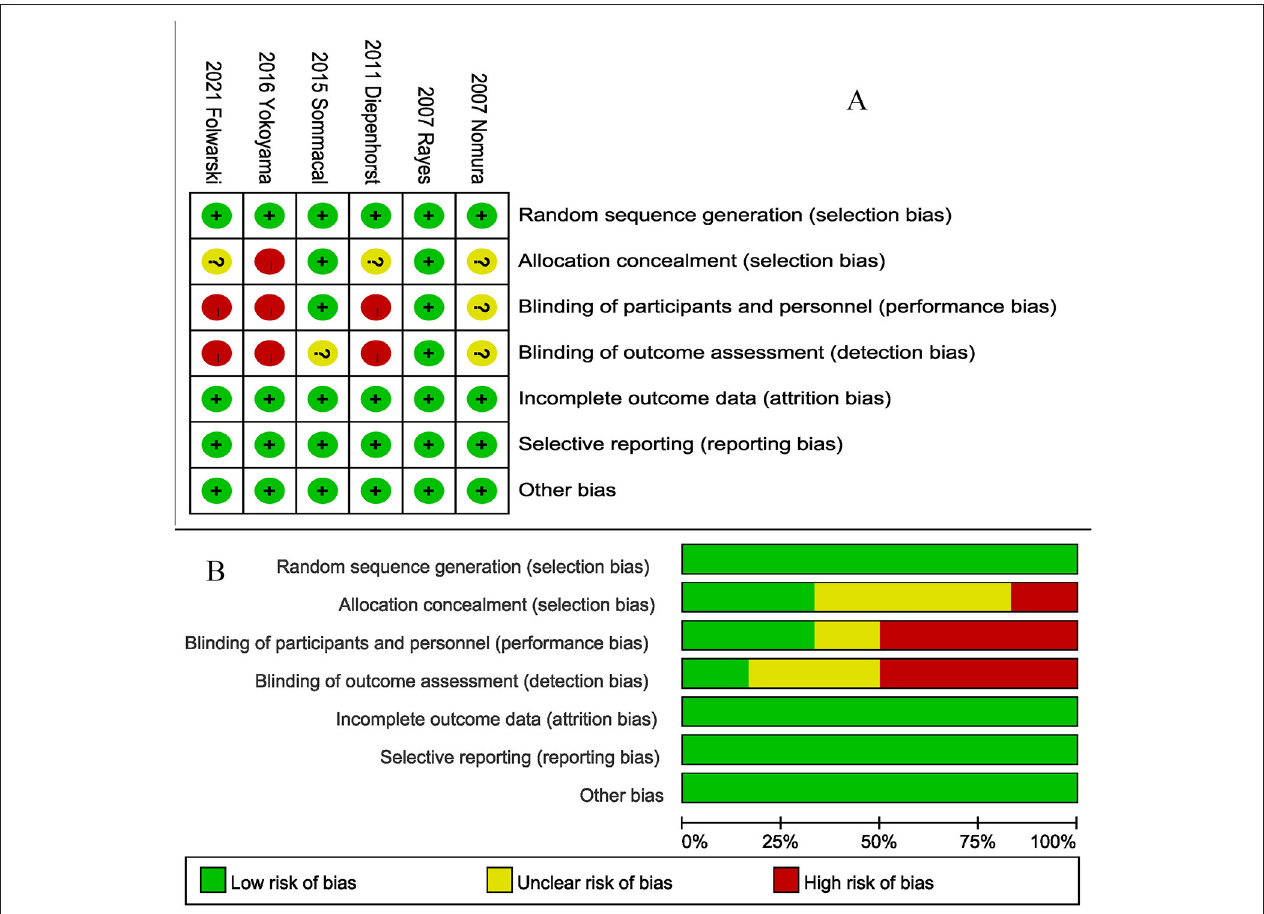
FIGURE 2 | Risk of bias for each included study. (A) Risk of bias summary. (B) Risk of bias